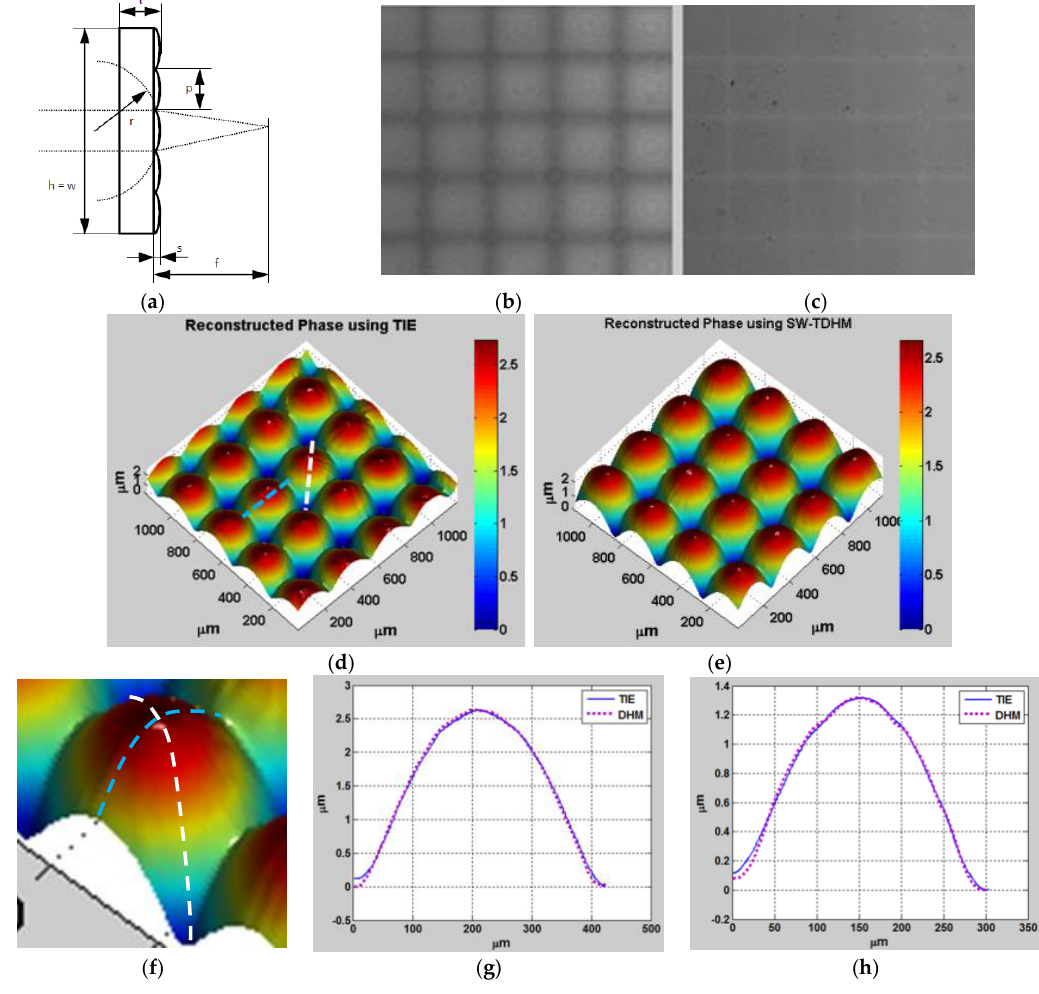
Figure 6. ( a ) An illustration of the lens array; ( b,c ) single shot intensity distribution from the mirror and the SLM, respectively; ( d ) 3D phase profile obtained using TIE; ( e ) 3D unwrapped reconstructed profile using DHM; ( f ) zoomed in area of the lens array showing the profile locations. Comparison between the TIE and DHM techniques along the dashed white line ( g ); and the dashed blue line ( h ).